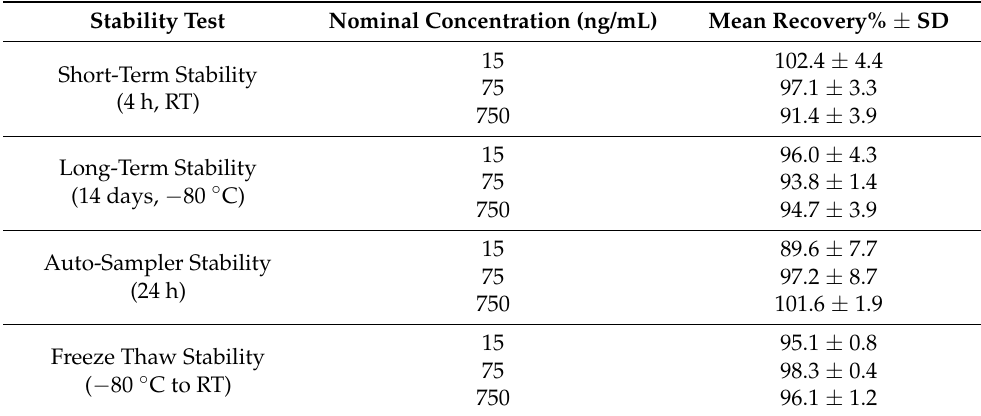
Table 2. Stability of OJT007 in rat plasma, expressed as a percentage of the nominal concentration [ n = 3; mean ( ± SD)].